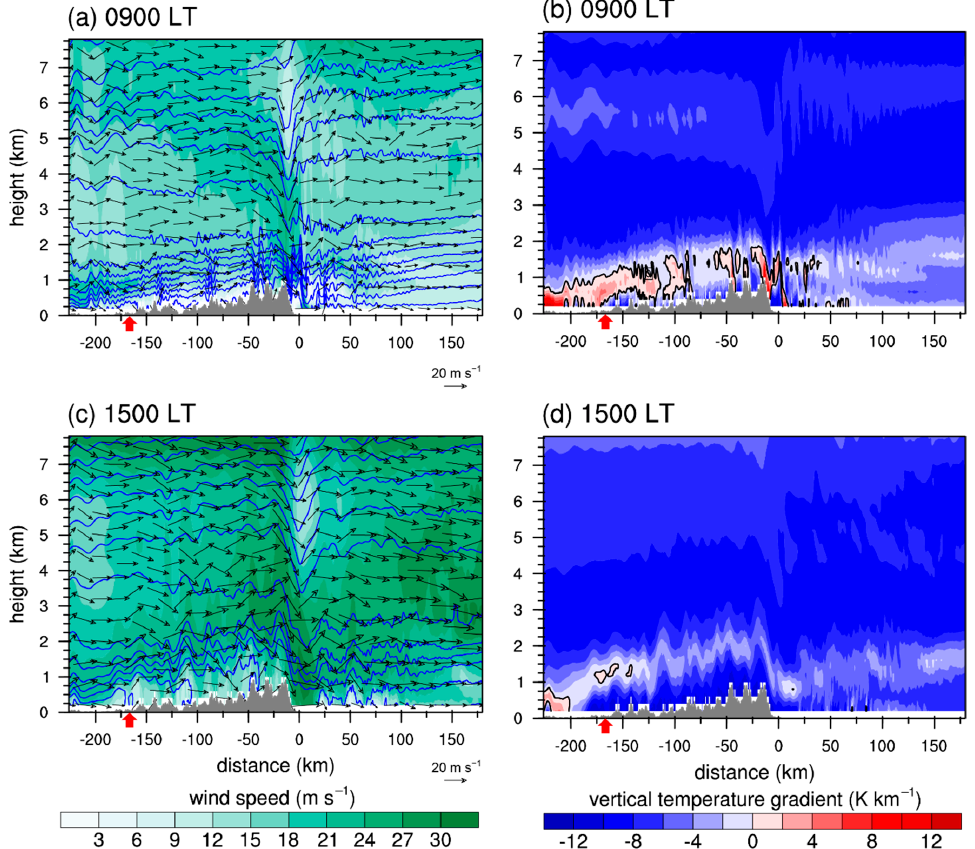
Figure 6. Vertical cross-sections of the potential temperature (blue lines in a , c ), wind speed ( a , c ), wind vector ( a , c ), and vertical temperature gradient ( b , d ) along C1 at ( a , b ) 0900 LT and ( c , d ) 1500 LT. The reference point on the horizontal axis (0 km) indicates the location of Yangyang station. The red arrow on the horizontal axis indicates the location of Osan station. The zero vertical temperature gradient lines are indicated by black lines.